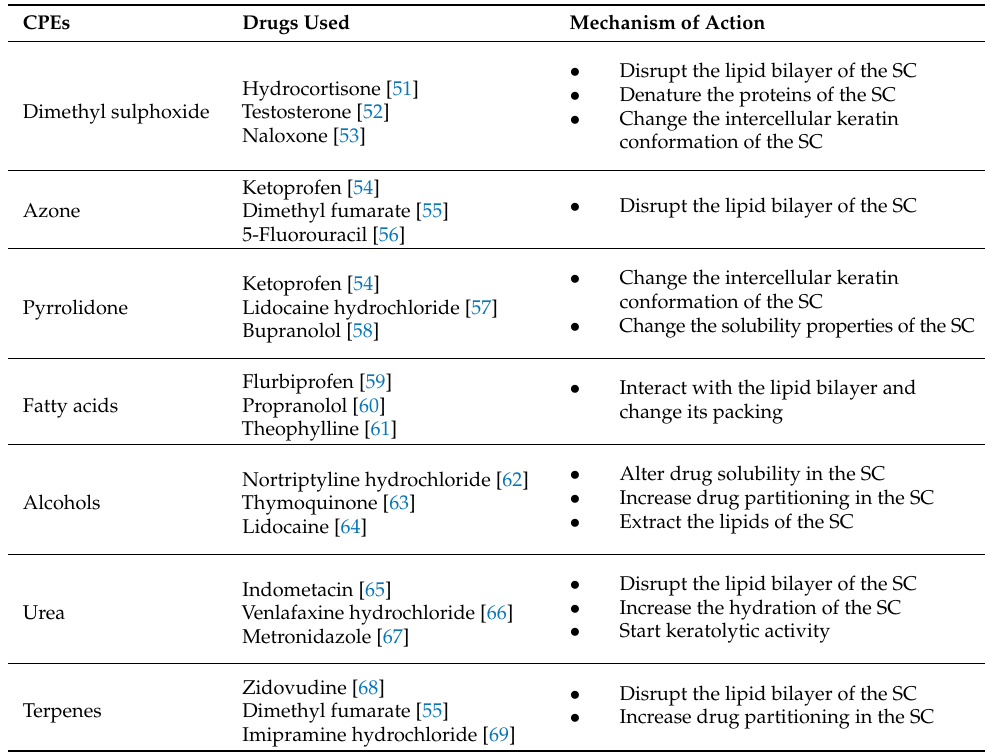
Table 1. List of transdermal chemical penetration enhancers with active ingredients and mechanisms of